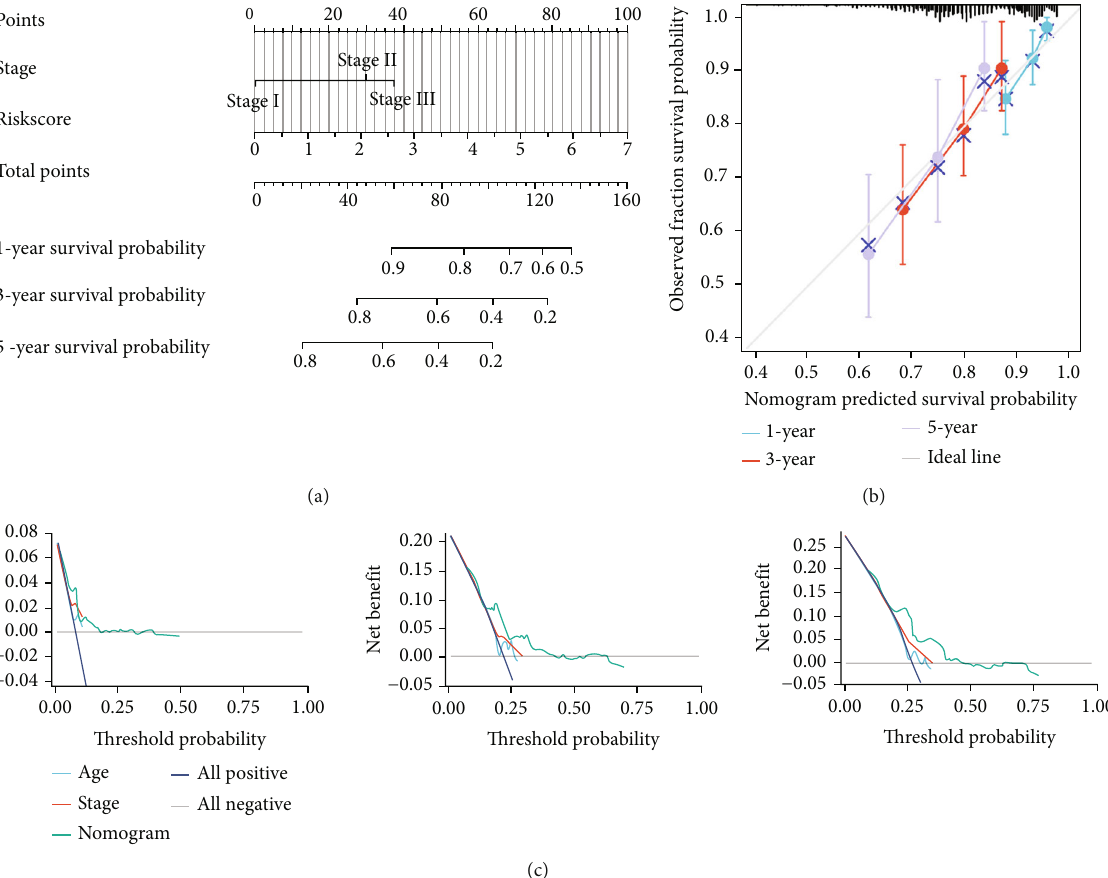
Figure 8: The establishment and veri fi cation of a PPAR-Riskscore-based prognostic nomogram. (a) A nomogram for predicting 1-, 3-, and 5-year survival possibilities of patients with COAD. (b) Plots depict the calibration of the nomogram based on risk score in terms of consistency between predicted and observed 1-, 3-, and 5-year outcomes. (c) Decision curve analyses of the nomogram for 1-, 3-, and 5- year